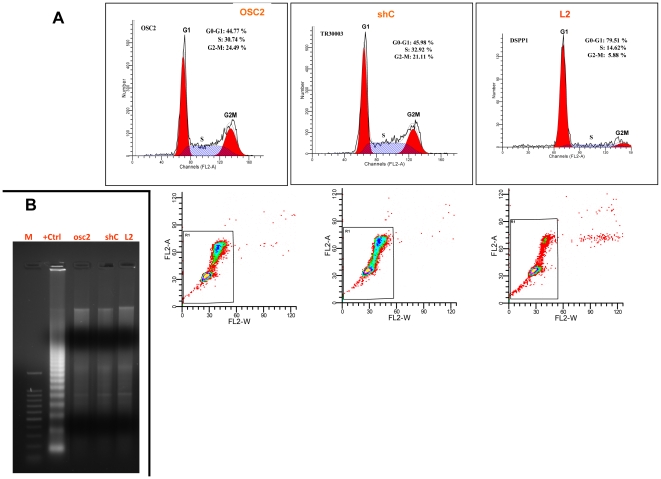

DSPP-silencing reduces G0/G1 arrest in OSC2 cells.(A) Flow cytometric analysis shows proportion of DSPP-silenced L2 cells in G0/G1 phase significantly increased (79.51%) compared with parental OSC2 (44.7%) and shC controls (45.98%). (B) Conversely, DNA laddering experiments shows no significant difference in rate of apoptosis between L2 cells and controls. This result indicates that DSPP-silencing alone does not increase the rate of apoptosis in OSC2 cells.